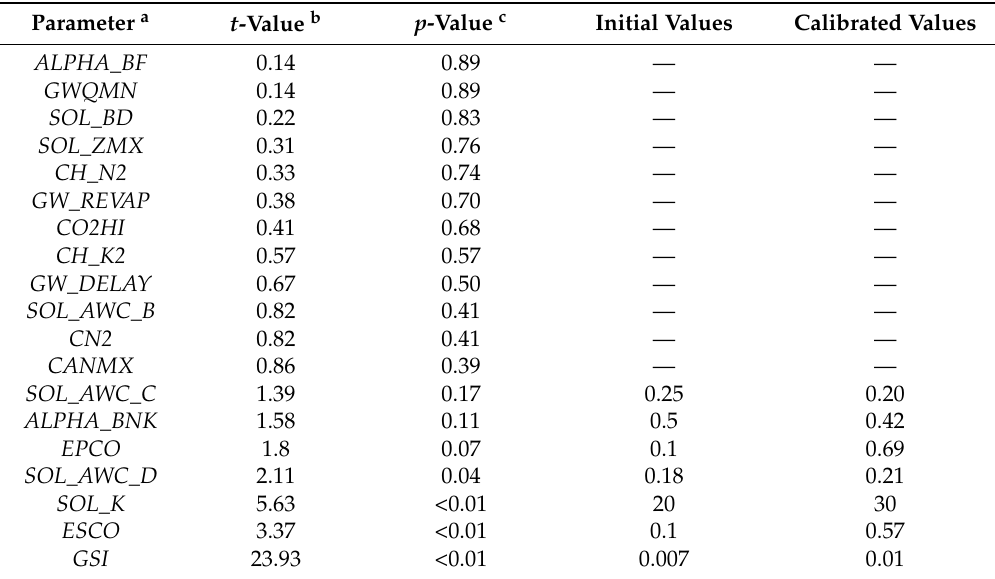
Table 7. Global sensitivities of the parameters that affect daily